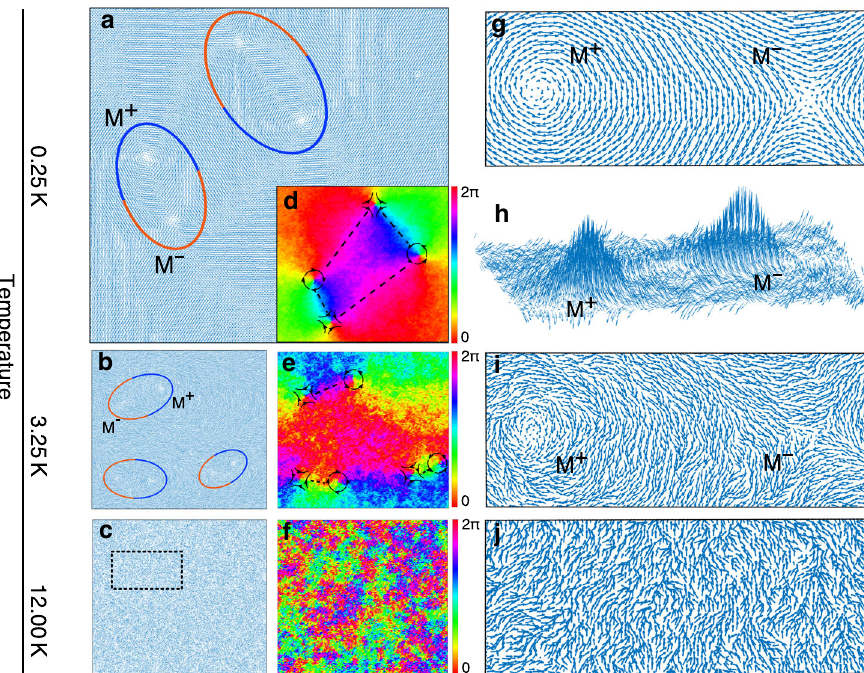
Fig. 3 Snapshots of Monte Carlo simulations of ML CrCl 3 . a – c Top views of the real-space magnetic moments from snapshots of MC simulations under different temperatures. The blue and red part of the ovals indicate the vortex and antivortex type meron defects, respectively. d – f are phase maps of in- plane magnetic moment component of ( a – c ). The schematic spin directions and the connections between defects are drawn to clarify the vortex/ antivortex type meron and the higher-order excitations. g , i , j Are enlarged views of the speci fi c defect pairs and the rectangular area from ( a – c ), respectively. h Side view of ( g ) with an enlarged z -axis ratio